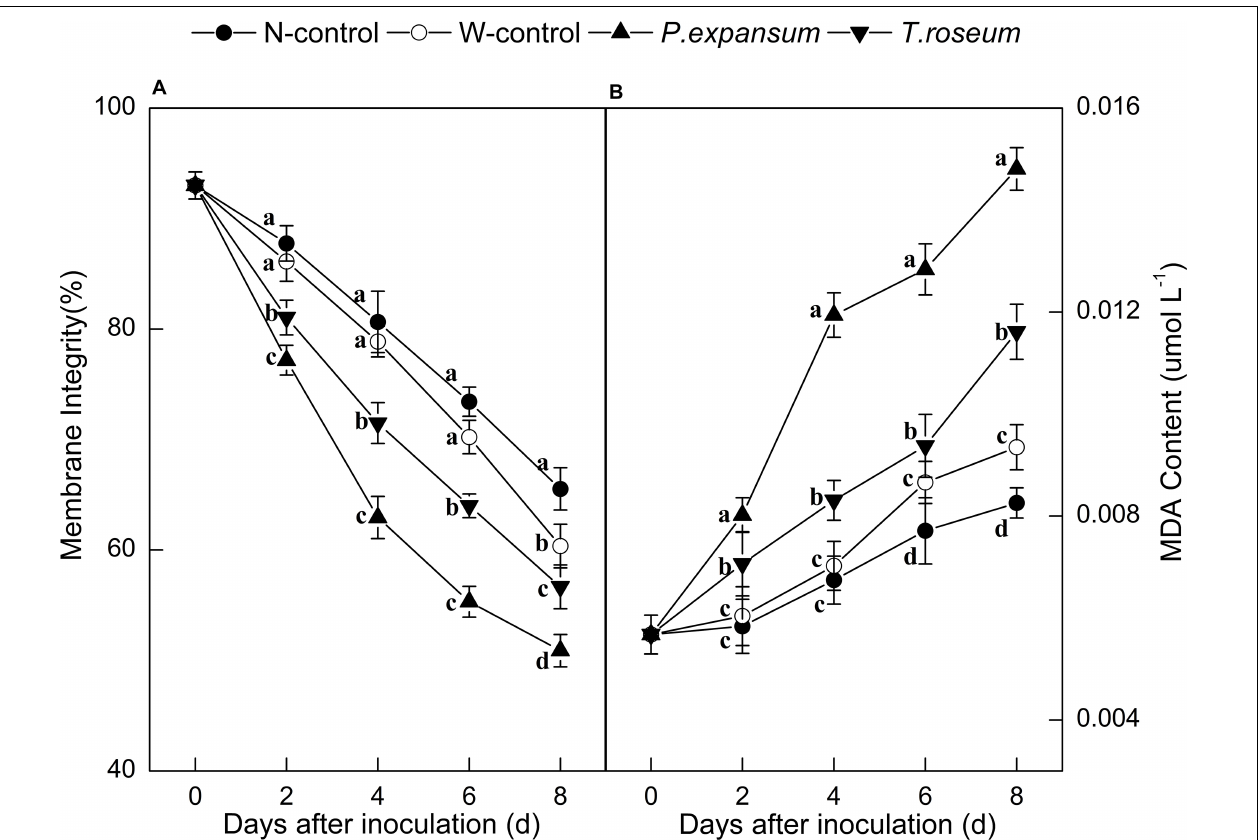
FIGURE 3 | Effects of P. expansum and T. roseum inoculation on membrane integrity (A) and MDA content (B) of apple fruit during storage. All data are expressed as means ± standard deviation of triplicate samples. Different letters indicate significant differences ( P < 0.05).